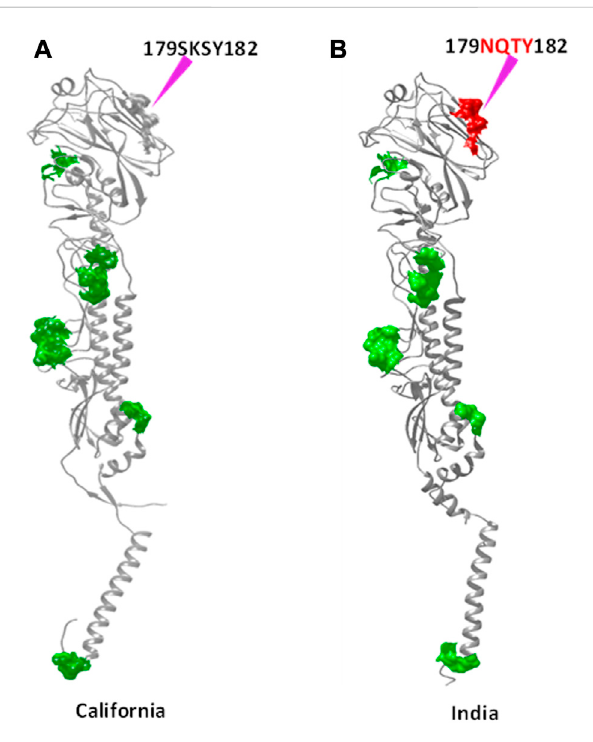
FIGURE 4 N-glycosylation sites observed in common with both HA Cal (A) and HA Ind (B) strains are shown in the green surface. The red surface indicates the newly formed N-glycosylation site due to mutation. The sites of mutation are indicated by purple